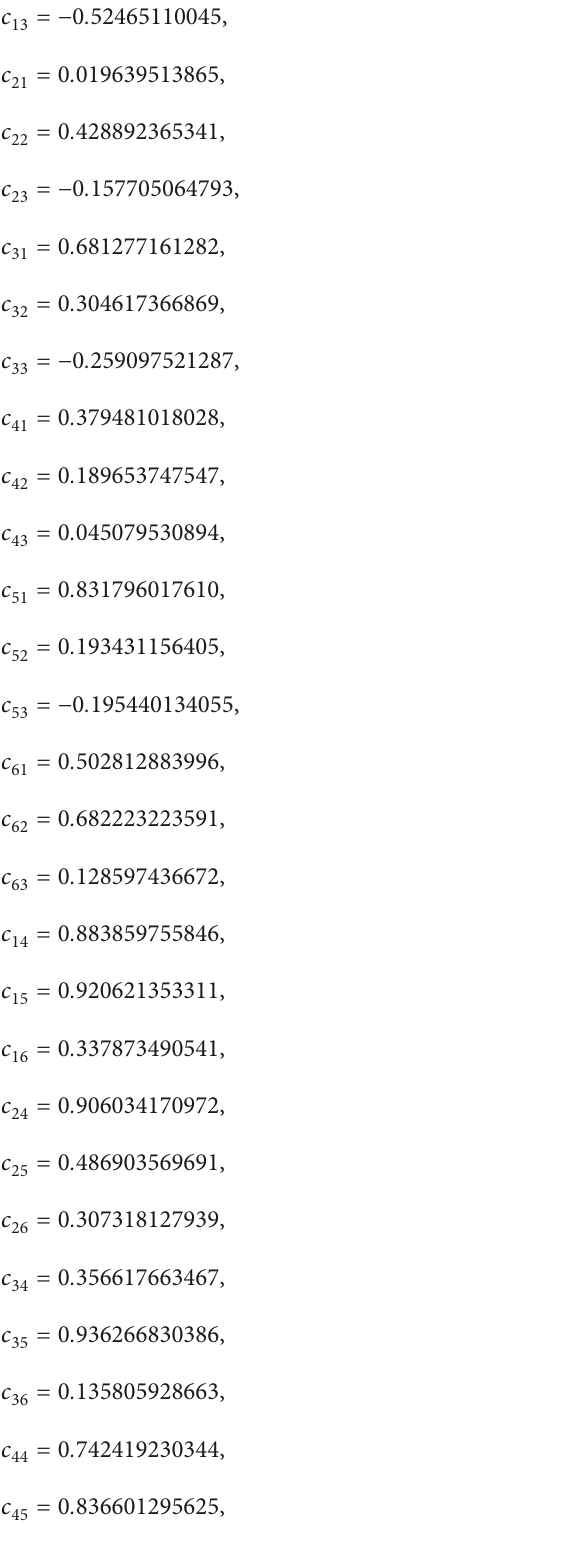
Figure 2 illustrates the error err � ‖ τ k ‖